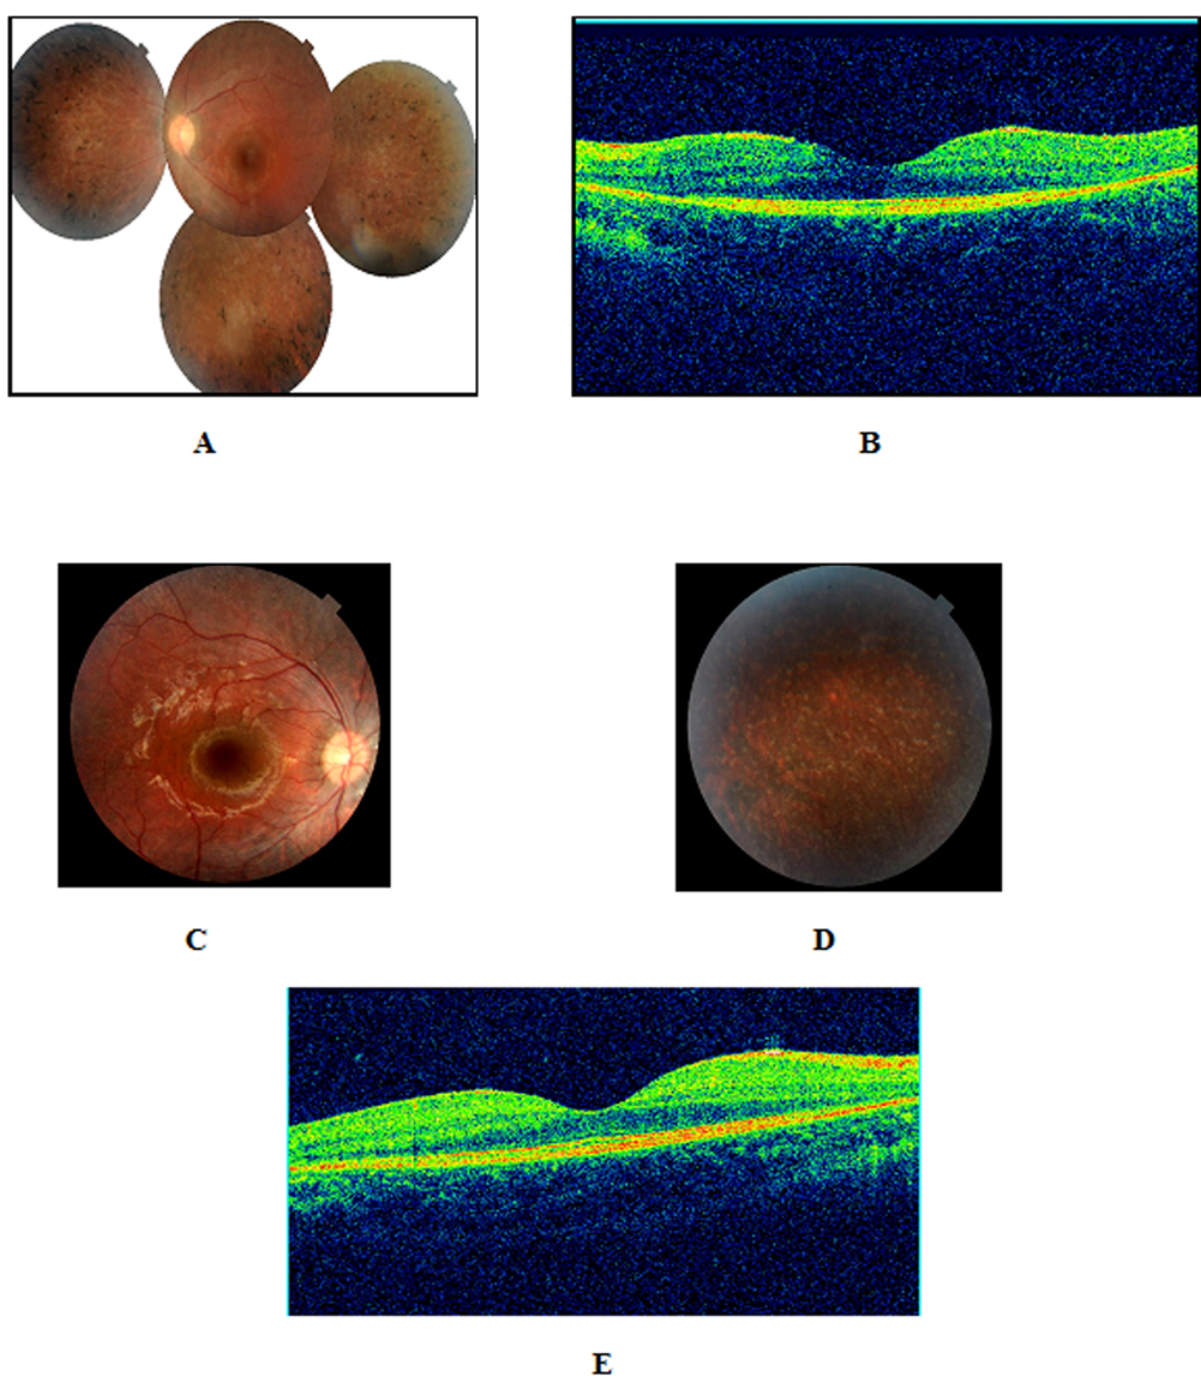
Fig 2. Retinal phenotypes of patients with mutations in Usher genes. A , Composite color fundus photograph of the left eye of a four-year-old girl (DF103-III-2) showing diffuse narrowing of the retinal arteries and hyperpigmentation in a bone-spicule configuration in the midperipheral retina. B , B-scan OCT imaging of the same eye showing a mild foveal atrophy (central macular thickness = 160 micrometers). C , Color fundus photograph of the posterior pole of the right eye of a six-year-old boy (DF103-III-1) with early stage retinitis pigmentosa shows no obvious abnormalities which may explain the misdiagnosis of the disease in some cases. D , Color fundus photograph of the peripheral retina showing a “ salt and pepper" appearance without the classical bone-spicule pigmentation. E , The fovea has a normal thickness on optical coherence tomography (180 micrometers).